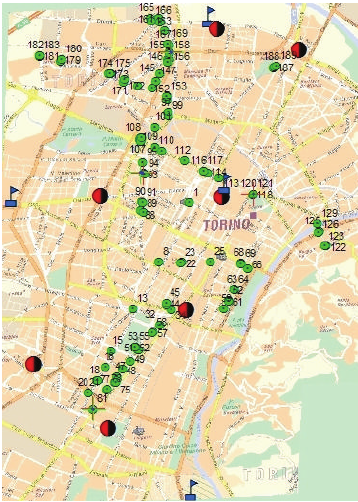
Figure 1: Turin vehicle tra ffi c, air, and meteorology monitoring network: green disk are the 107 tra ffi c counters, red and black disks are the pollution stations, and blue flags are the meteorological stations.